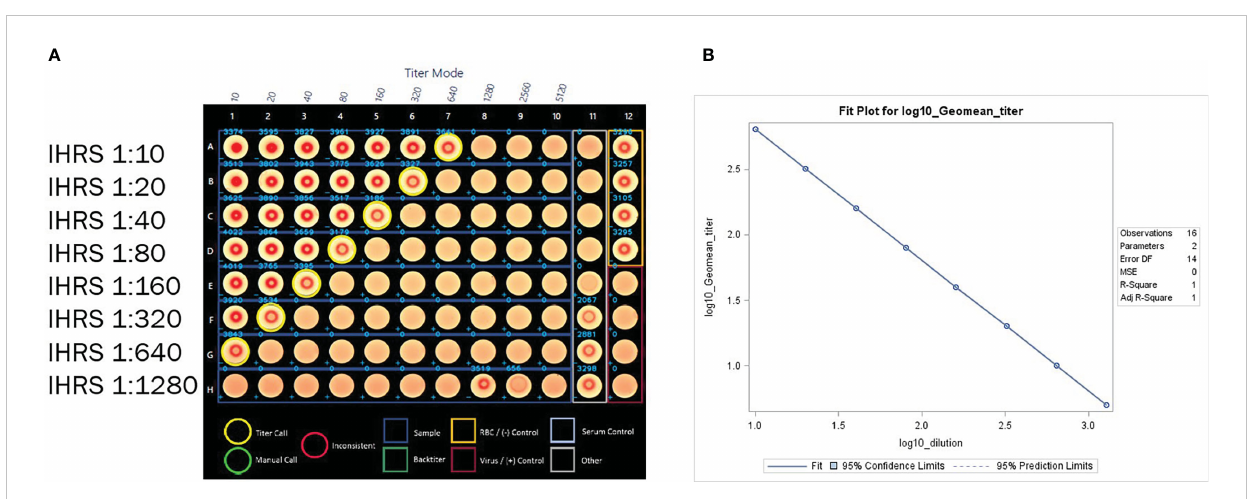
FIGURE 5 (A) HAI assay quali fi cation on H3N2 in fl uenza strain A/Texas/71/2017, linearity testing plate visual. A CypherOne instrument graphic demonstrating assay linearity, from a representative assay with the in-house reference standard (IHRS). The HAI titer decreased two-fold for each two-fold decrease in analyte concentration. (B) HAI Assay Quali fi cation on H3N2 in fl uenza strain A/Texas/71/2017, linearity testing results. The plot shows SAS output from REG procedure, showing the linear regression analysis between log10 GMT [plotted on y-axis] and log10 dilution [plotted on x-axis]. The resulting R 2 and R was